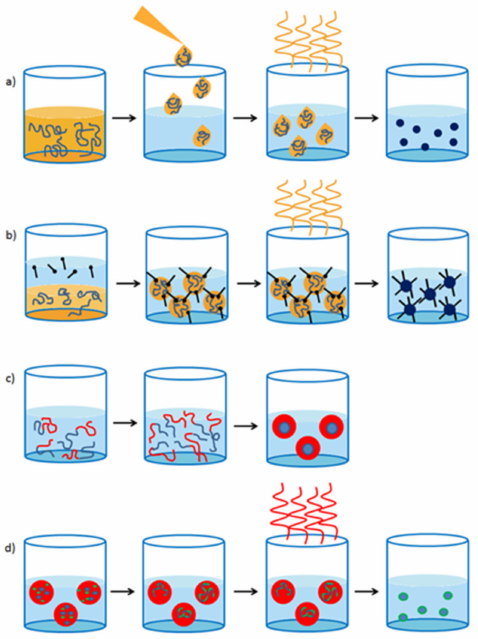
Figure 1. Conjugated polymer nanoparticle formulation via ( a ) the solvent exchange technique; ( b ) the mini-emulsion technique; ( c ) self-assembly and ( d ) emulsion